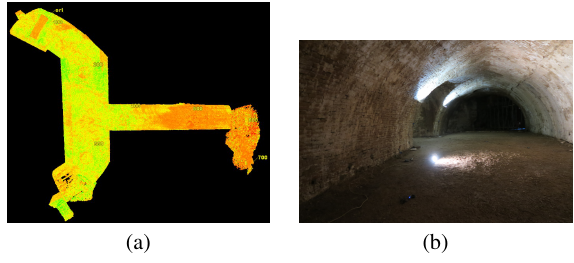
Figure 1. (a) Top view of Impossibile bastion, walls of Padova, Italy. Terrestrial laser scanner 3D reconstruction obtained with Leica ScanStation C10. (b) Inside view of the bastion.